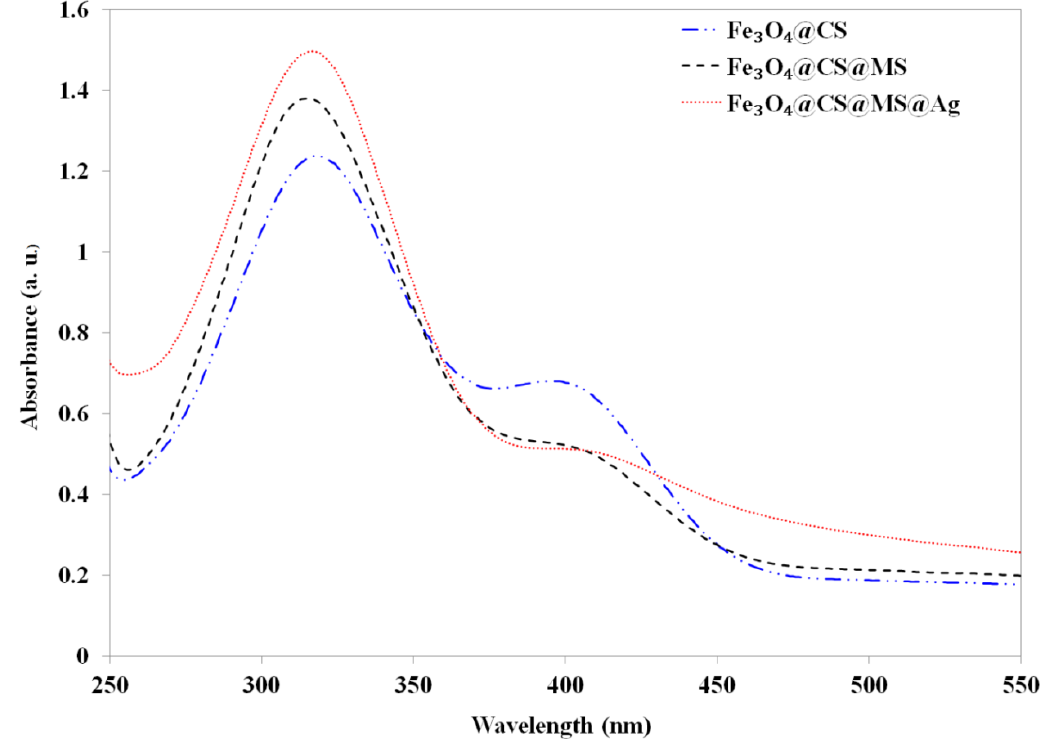
Figure 8. UV-Vis spectra for the reduction of 4-NP to 4-AP using 1.5 mg of each Fe 3 O 4 @CS ( blue line), Fe 3 O 4 @CS@MS ( black line) and Fe 3 O 4 @CS@MS@Ag (1.2 × 10 −6 mol Ag) ( red line) after 10 min.